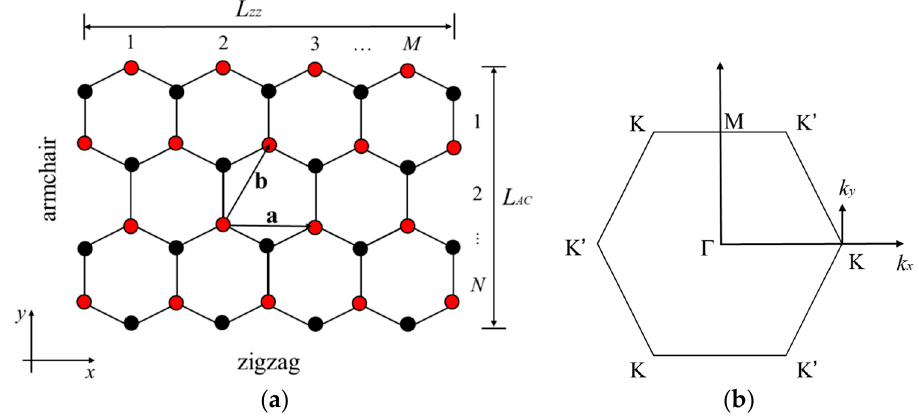
Figure 1. ( a ) Illustration of a monolayer rectangular graphene quantum dot (RGQD). The black and red circles are two types of carbon atoms, A and B. a and b are unit vectors. ( b ) The reciprocal lattice.